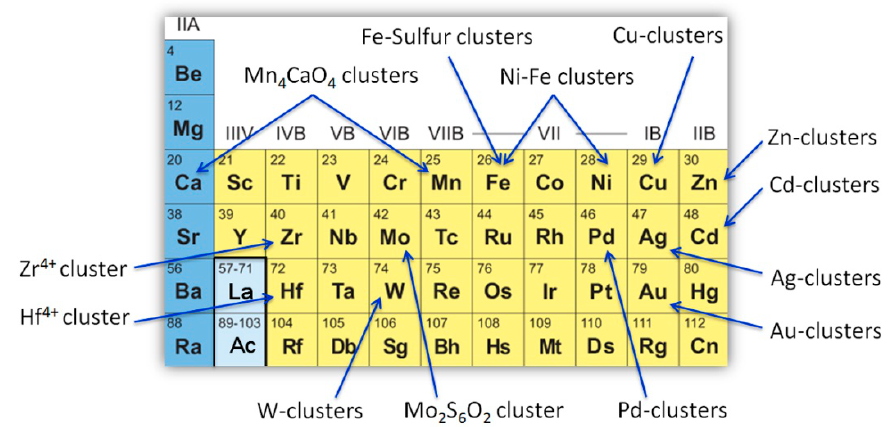
Figure 1. Artificial metalloproteins and metalloenzymes with diverse metal clusters shown in the periodic table.